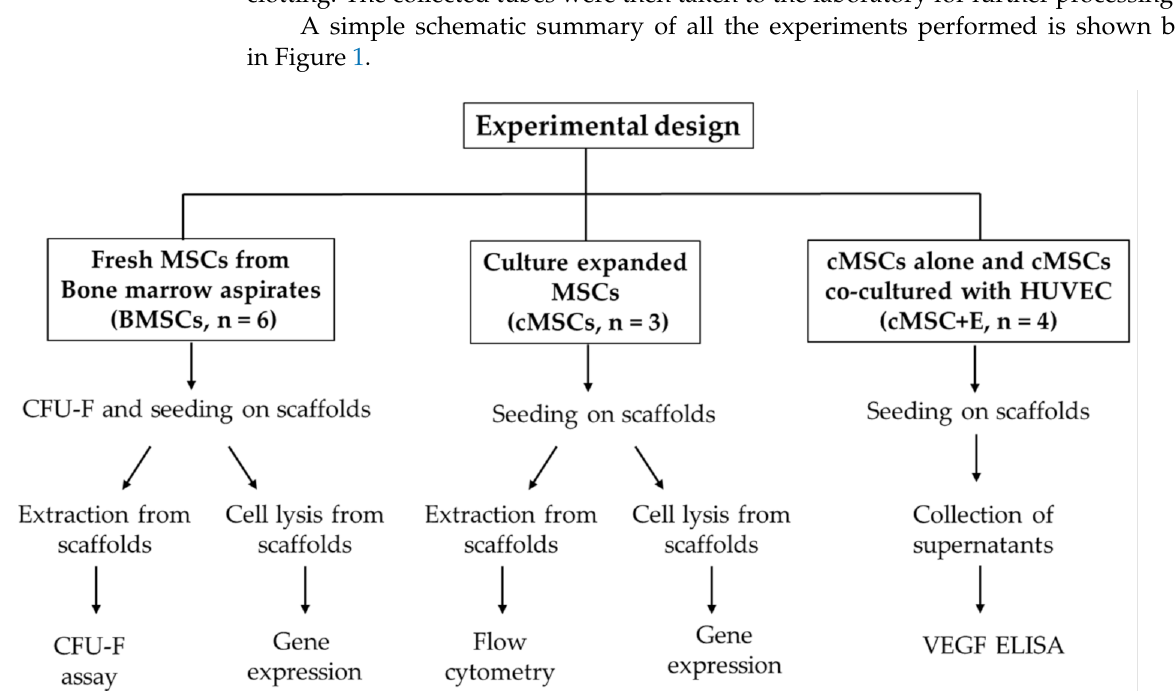
Figure 1. Schematic summary of all the experiments